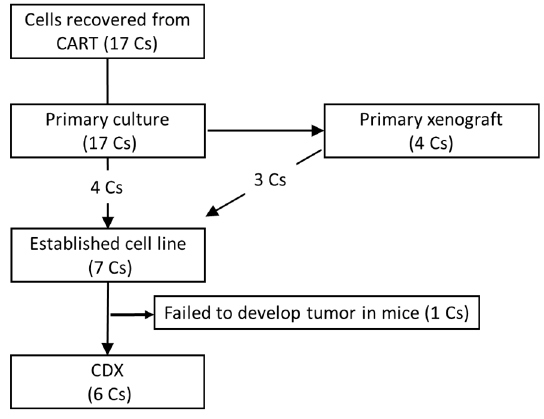
Figure 2. Diagram of cell lines established from CART cases. Out of 17 patients, seven gastric cancer cell lines were established. Six gastric cancer cell lines from CDX tumors in SCID mice. Cs: Cases . In summary, we established 35 gastric cancer PDX models as well as 32 gastric cancer cell lines, 21 of which were established from the same patients.